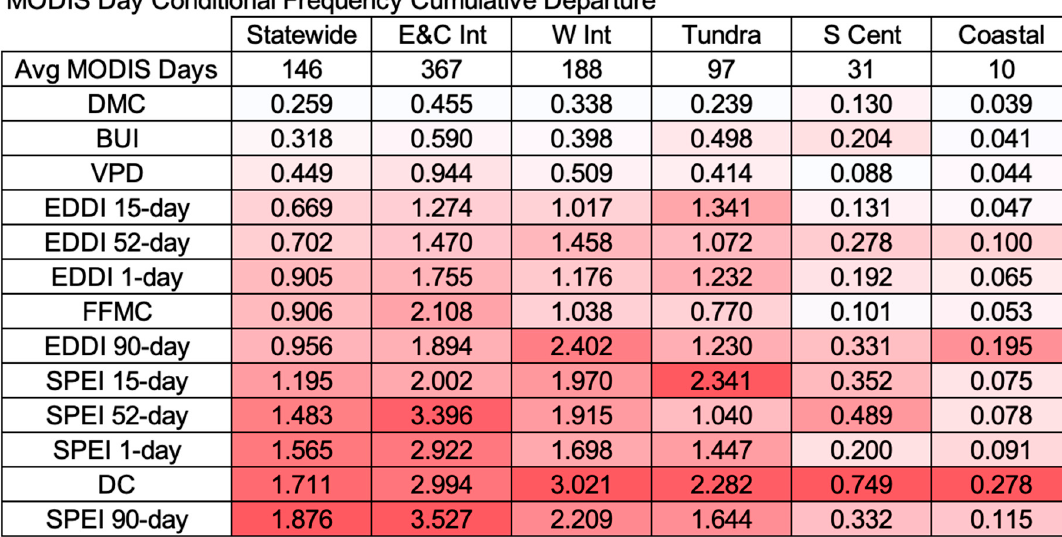
Figure 8. MODIS Day conditional frequency cumulative departure helps to identify how well each index identifies active fire days. The color ramp highlights comparison of cumulative departure scores for each index (darker red shading indicates larger departures) within each column.